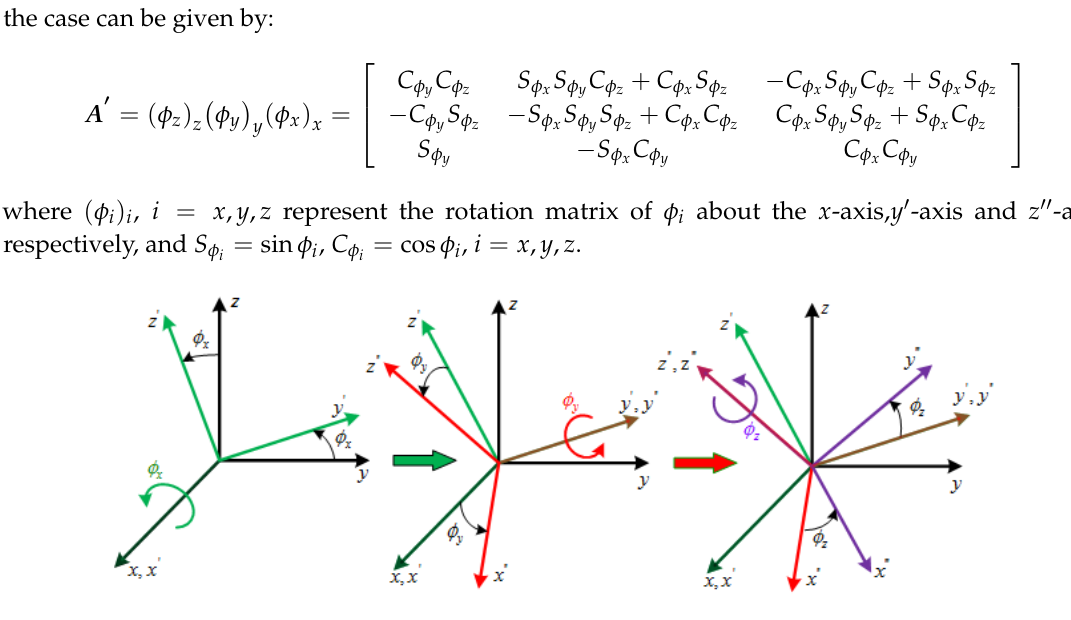
Figure 3. Case-Reference Coordinates and Reference